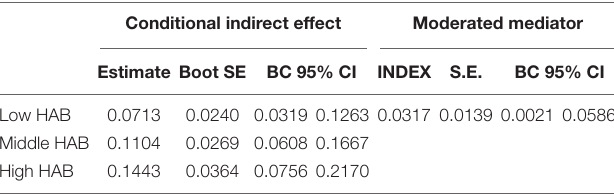
TABLE 8 | Bootstrap results for the moderated mediation effect ( n =